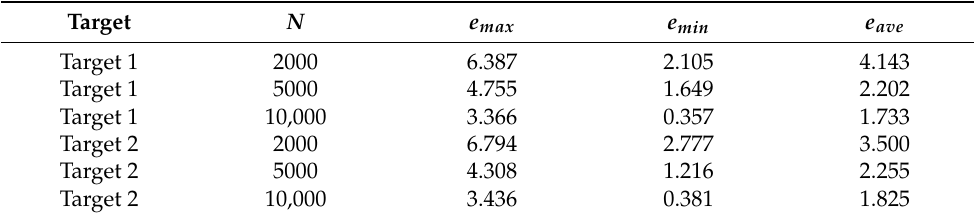
Table 4. Comparison of positioning errors with different number of